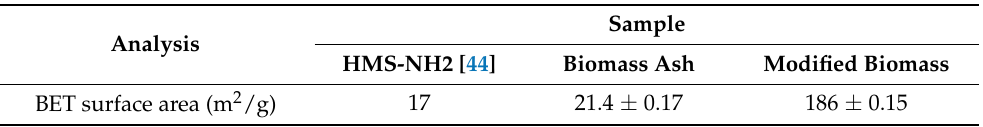
Table 1. Comparison of the Brunauer–Emmett–Teller (BET) analysis of functionalized hexagonal mesoporous silica, biomass ash, and synthesized matrix. Reproduced with permission from our previous research results [34]. HMS-NH2 is non-functionalized mesoporous